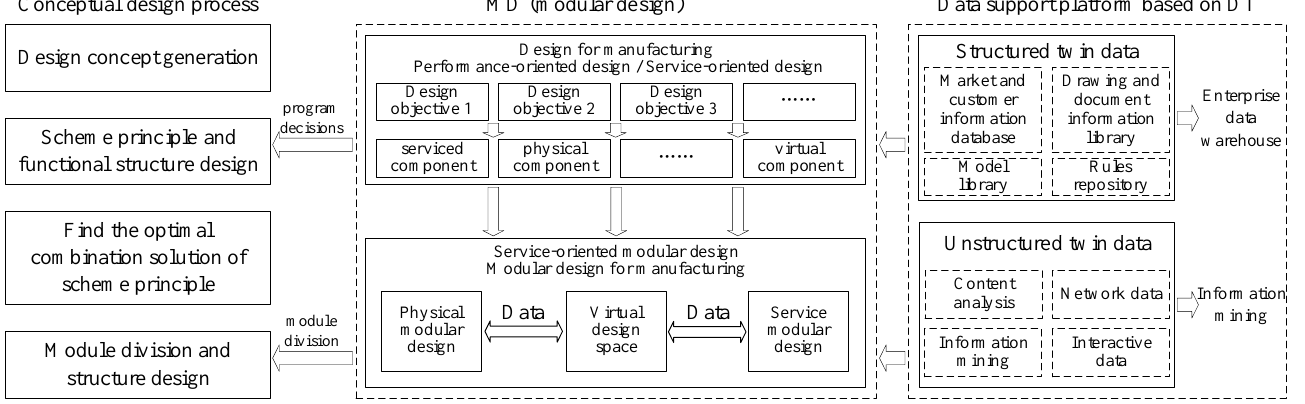
Figure 6. Product conceptual design based on DMS-DT.